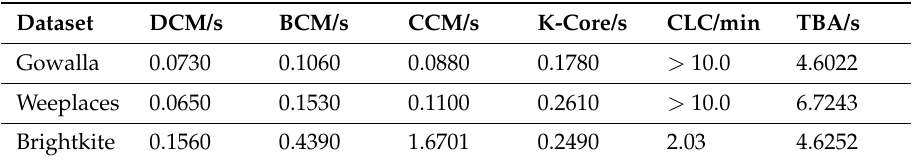
Table 3. The CPU time of six measures on three real